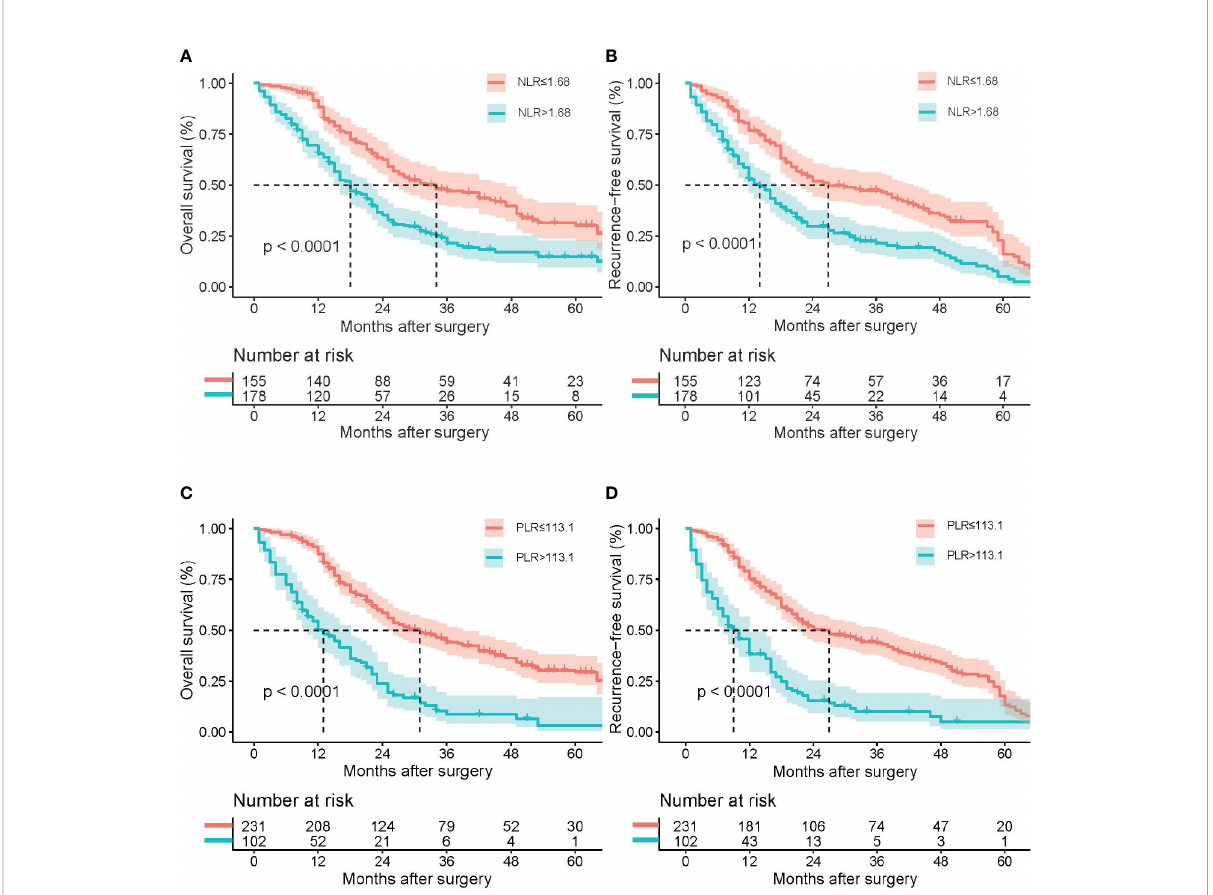
FIGURE 3 Kaplan – Meier survival analysis indicated that patients with NLR ≥ 1.68 had a shorter RFS and OS; patients with PLR ≥ 113.1 had a shorter RFS and OS. Overall survival (A) and recurrence-free survival (B) curve comparisons between patients with NLR ≥ 1.68 and NLR < 1.68; overall survival (C) and recurrence-free survival (D) curve comparisons between patients with PLR ≥ 113.1 and PLR <